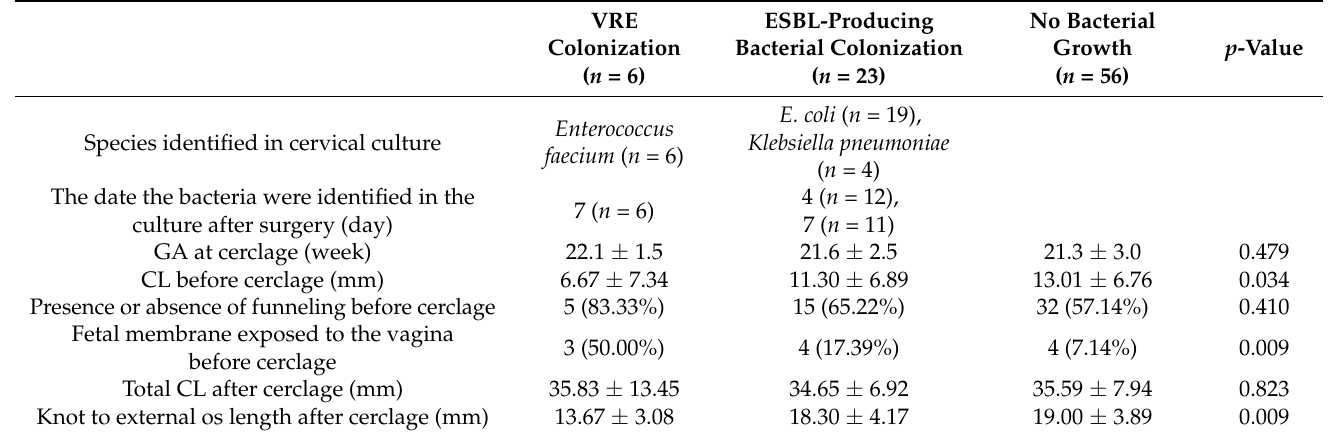
Table 2. Clinical/laboratory findings during emergency cerclage.